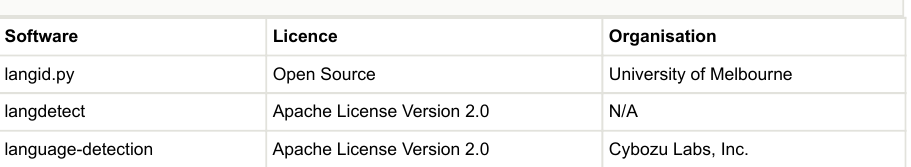
Figure 11. The distribution of languages across the specimen and herbaria. EN=English, FR=French, LA=Latin, ET=Estonian, DE=German, NL=Dutch, PT=Portuguese, ES=Spanish, SV=Swedish, RU=Russian, FI=Finnish, IT=Italian, ZZ=Unknown. The codes for the contributing herbaria are listed in Table 11 (from Dillen et al. 2019). A number of off-the-shelf software tools can be used to perform language identification, examples of which can be seen in Table 6. The given tools can all be integrated into larger software applications. Table 6. Language identification software tools and their